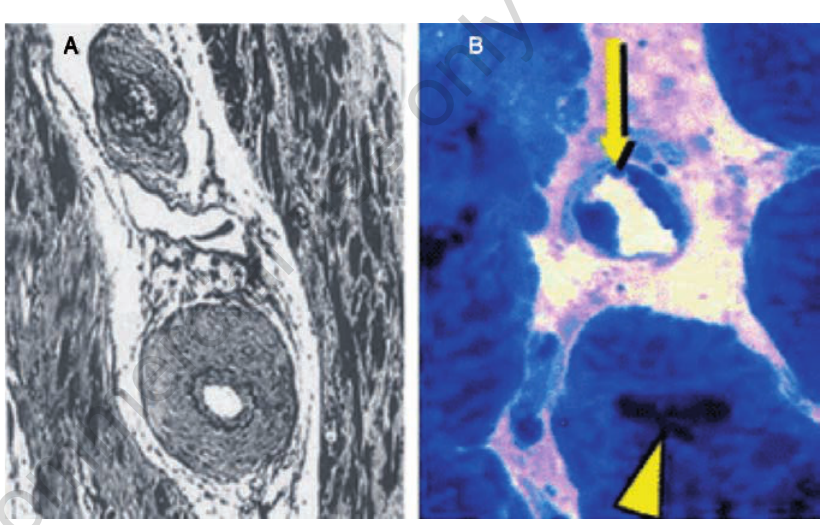
Figure 7. Gb3 inclusions in the endothelium and cardiomyocytes. Panel A shows an intra- mural coronary artery in a patient with hypertrophic cardiomyopathy. Wall thickening is due primarily to severe thickening of medial wall, while the intima is mildly thickened. Panel B shows interstitial capillaries in the myocardium of a patient with Anderson-Fabry disease. Glycosphingolipid inclusions are present in the endothelium (arrow) and cardiomy- ocytes (arrowhead) ( Reprinted with permission of the publisher from Camici e Crea 58 ).